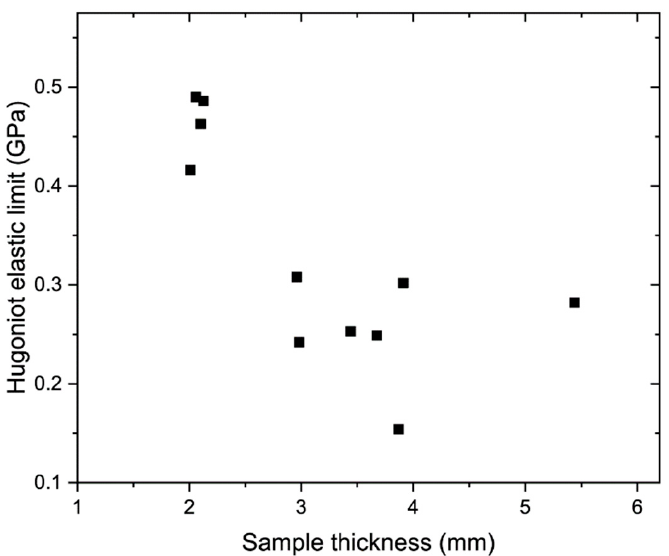
Figure 12. Overall Hugoniot elastic limit versus the sample thickness data points.